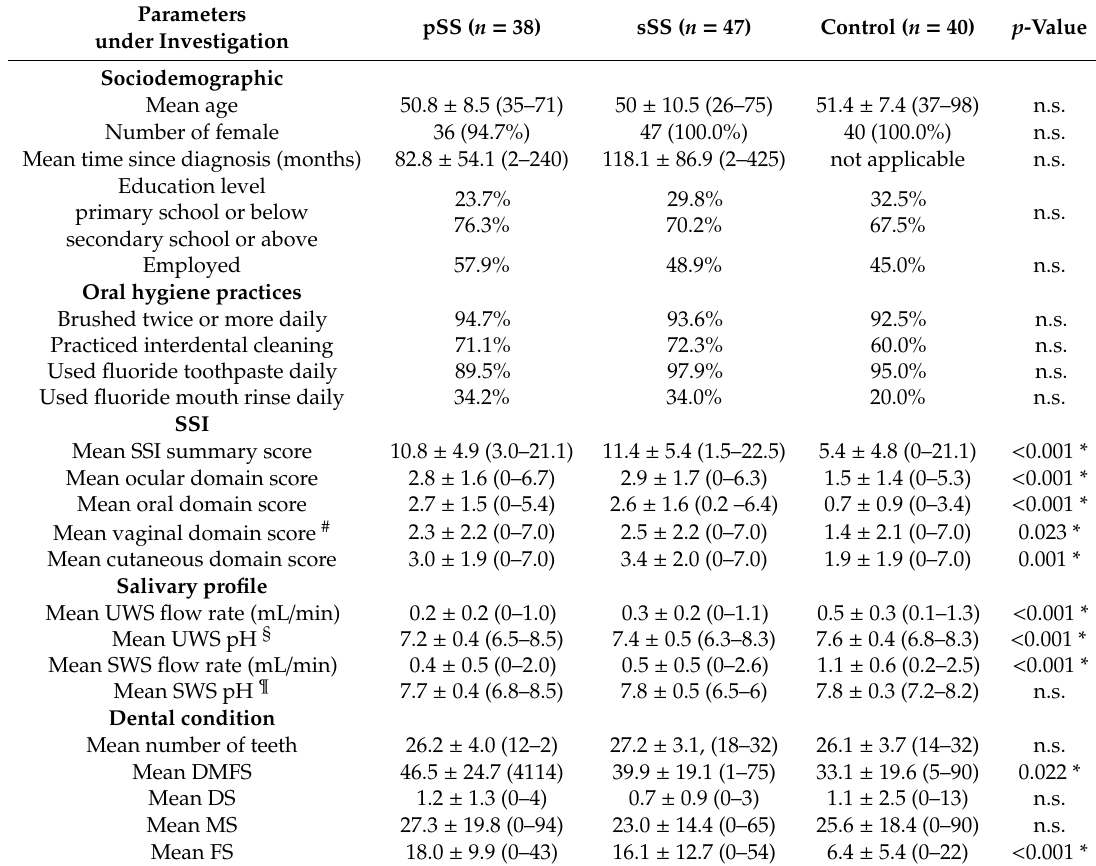
Table 1. Socio-demographic profile, oral hygiene practice, Sicca Symptoms Inventory (SSI) scores, salivary profile and dental condition by